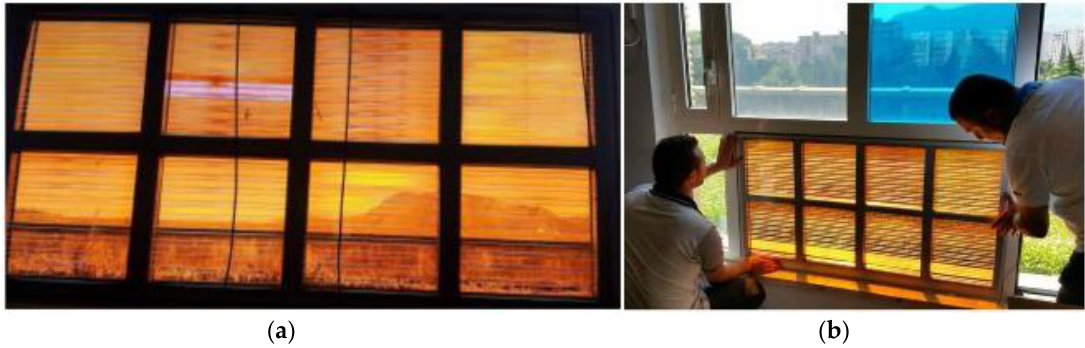
Figure 7. Set-up of the three PV vertical structures. DSSC PV wall system, made by Daunia solar cell: ( a ) assembly of 8 modules; ( b ) photograph taken during installation on the window.